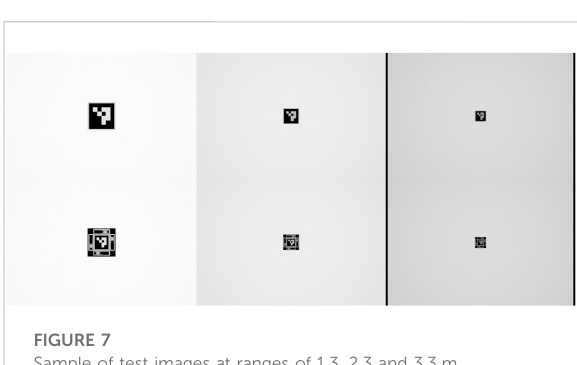
FIGURE 7 Sample of test images at ranges of 1.3, 2.3 and 3.3